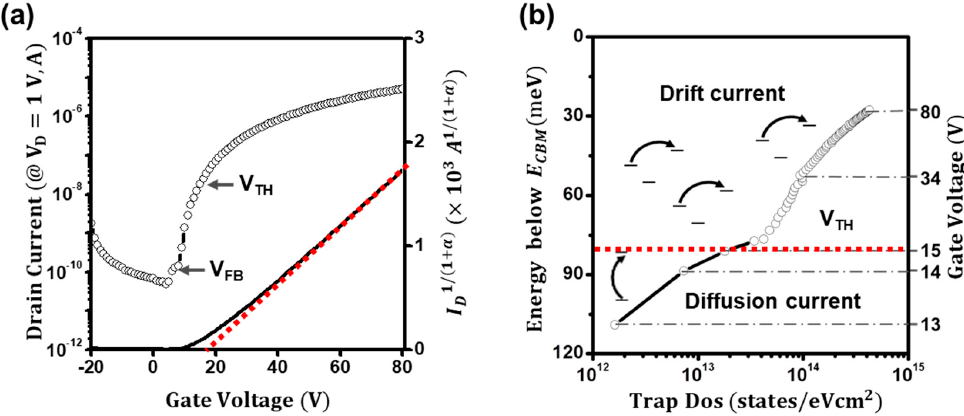
Figure 5. ( a ) The transfer curves and the power-law-term-removed threshold-voltage extraction of the ZnO TFTs. ( b ) Extracted charge trap density of states (DOS) of the ZnO TFTs.